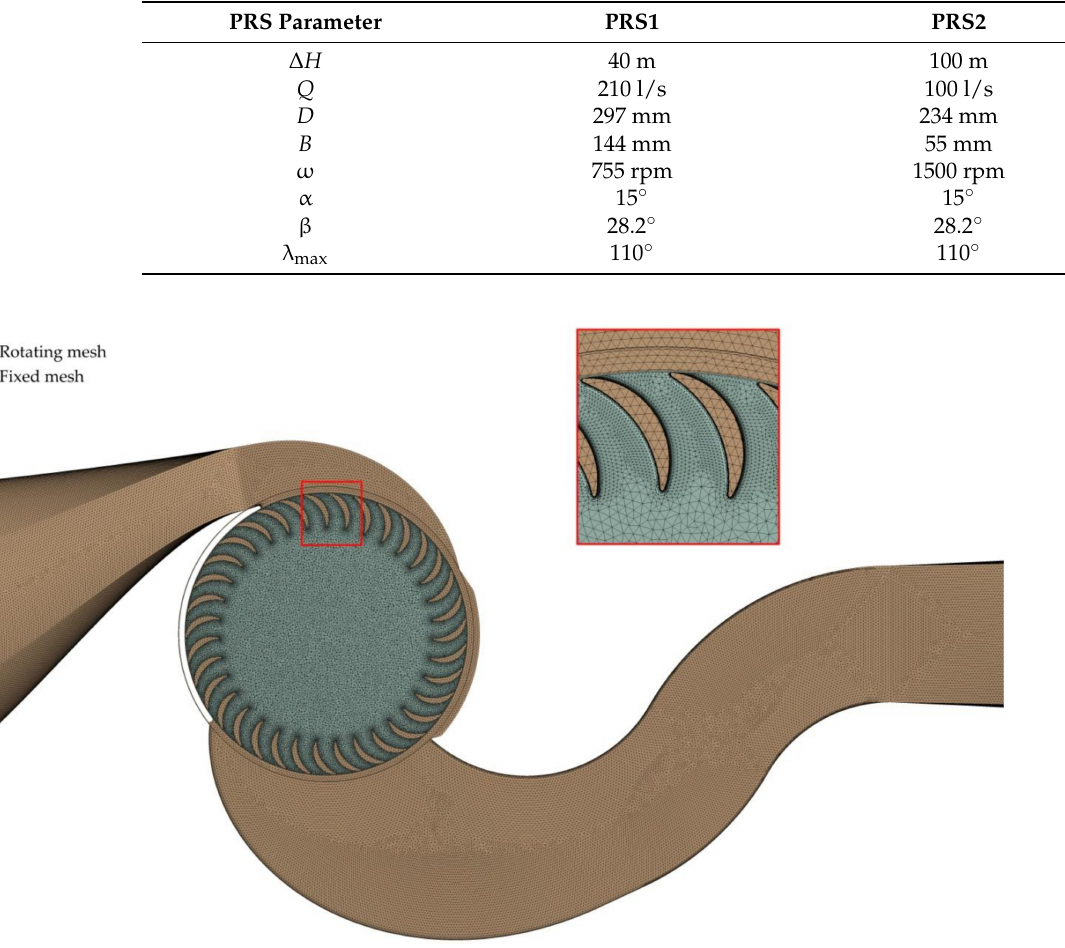
Figure 2. Three-dimensional (3D) computational mesh of the PRS1 turbine. Note that with more than 14 million elements in the rotor domain, the shaft torque increment becomes negligible. For this reason, we selected this grid as the optimal one. Reynolds-averaged Navier Stokes (RANS) equations [12,18]. CFX gives the option